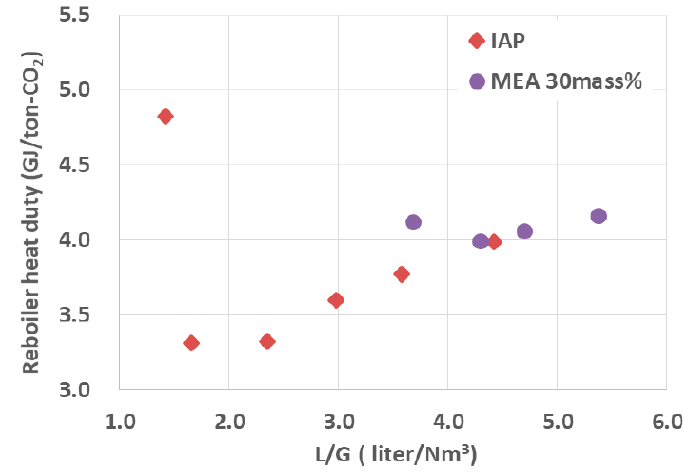
Figure 6. Reboiler heat duty outcomes for MEA 30mass% and IAP .